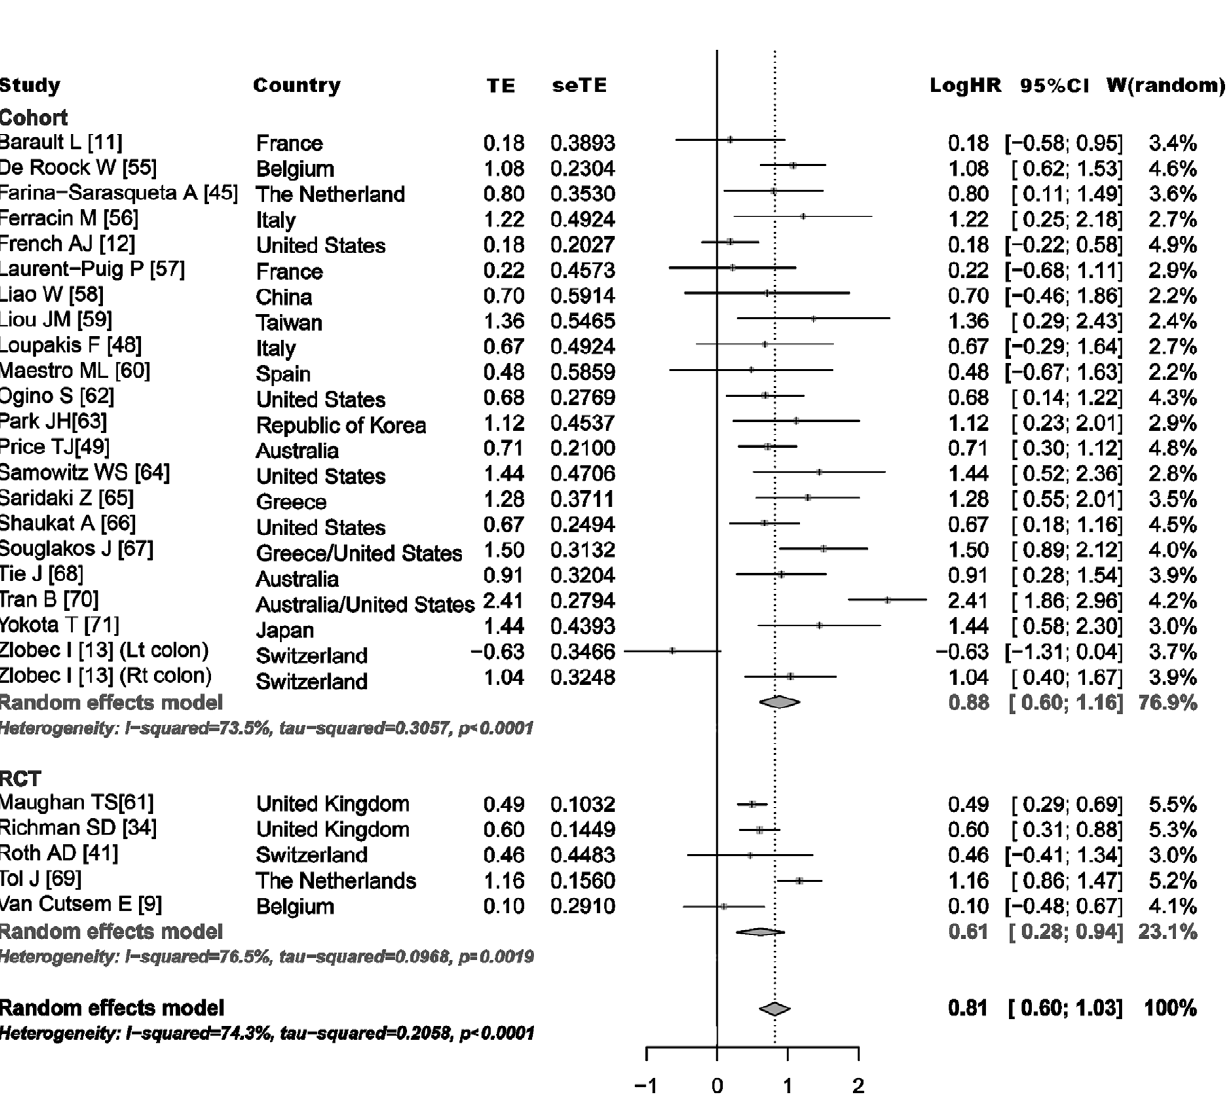
Figure 2. Random effect model of Log hazard ratio (LogHR) with 95% confidence interval for studies comparing the effect of BRAF- V600E mutation on overall survival of colorectal cancer patients. A LogHR , 0 implies a survival benefit for patients with BRAF mutation. The square size indicates the power of each study in meta-analysis based on the number of patients in that study. The center of diamond shape at the lowest part indicates the combined LogHR for meta-analysis and its extremities the 95% confidence interval.